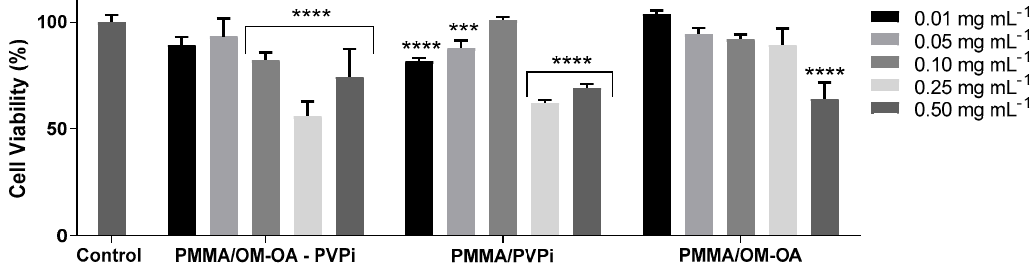
Figure 9. Evaluation of cytotoxic activity of poly(methyl methacrylate) / magnetic oxide coated with oleic acid / poly(vinyl pivalate)—(PMMA / OM-OA / PVPi), poly(methyl methacrylate) / poly(vinyl pivalate)—(PMMA / PVPi) and poly(methyl methacrylate) / magnetic oxide coated with oleic acid—(PMMA / OM-OA) in murine melanoma tumor cell lines, B16F10, after 24h exposure in the concentrations of 0.01 mg · mL − 1 , 0.05 mg · mL − 1 , 0.10 mg · mL − 1 , 0.25 mg · mL − 1 , and 0.50 mg · mL − 1 . The asterisks are related to the statistical significance associated with di ff erent confidence levels: * for 95% with p ≤ 0.05, ** 99% with p ≤ 0.01, *** 99.9% with p ≤ 0.001 and **** 99.99% with p ≤ 0.0001.